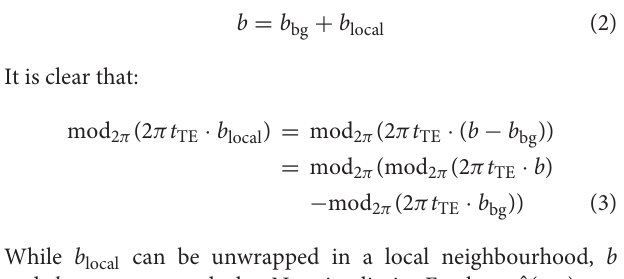
ˆ ϕ − ϕ bg (cid:1) (cid:0)